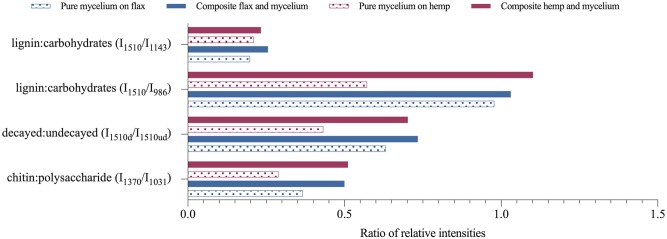
Ratios of the relative intensities.Aromatic skeletal vibration in lignin I1510 against undecayed I1510ud fibres, carbohydrate bands I986 (assigned to CH-deformation in cellulose) and I1143 (assigned to C-O-C vibration in cellulose and hemicellulose), C-H bending mode of chitin I1370 and the C-C stretching of polysaccharides I1031 of pure mycelium without fibres (pattern), and hemp and flax composite (solid).